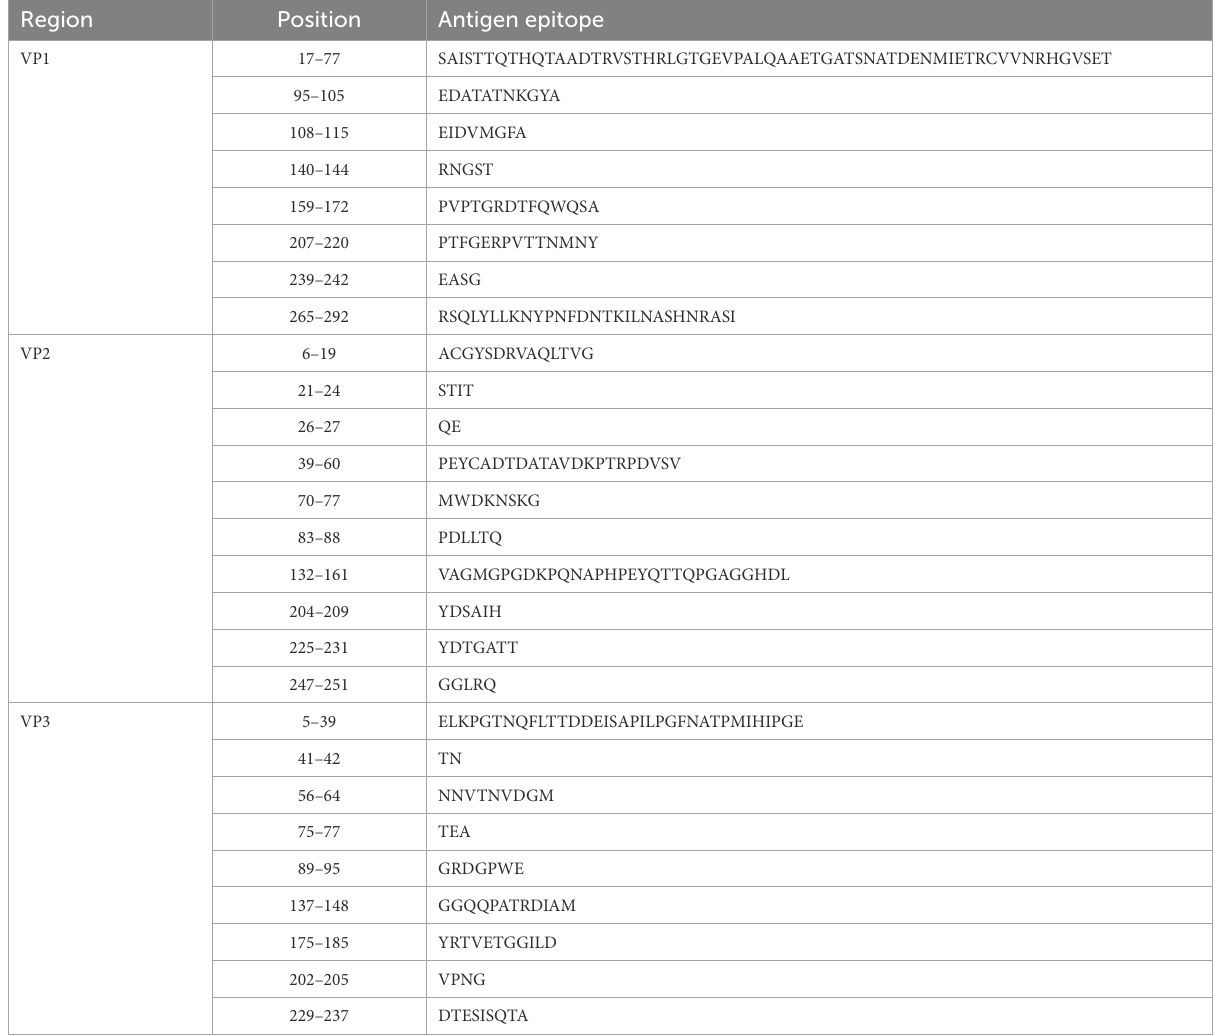
TABLE 3 The antigen sites of CVA12 prototype strain (AY421768.1/Texas-12) were predicted through online websites (IEDB.org: Free Epitope Database and Prediction Resource). Region Position Antigen epitope